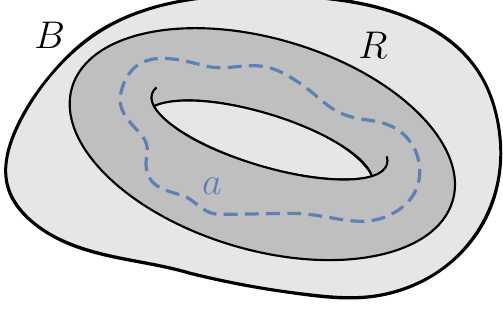
Figure 1. We show an operator a which is non-local in the topologically non-trivial region R . However, the same operator a can be locally generated in the topologically trivial region B containing R